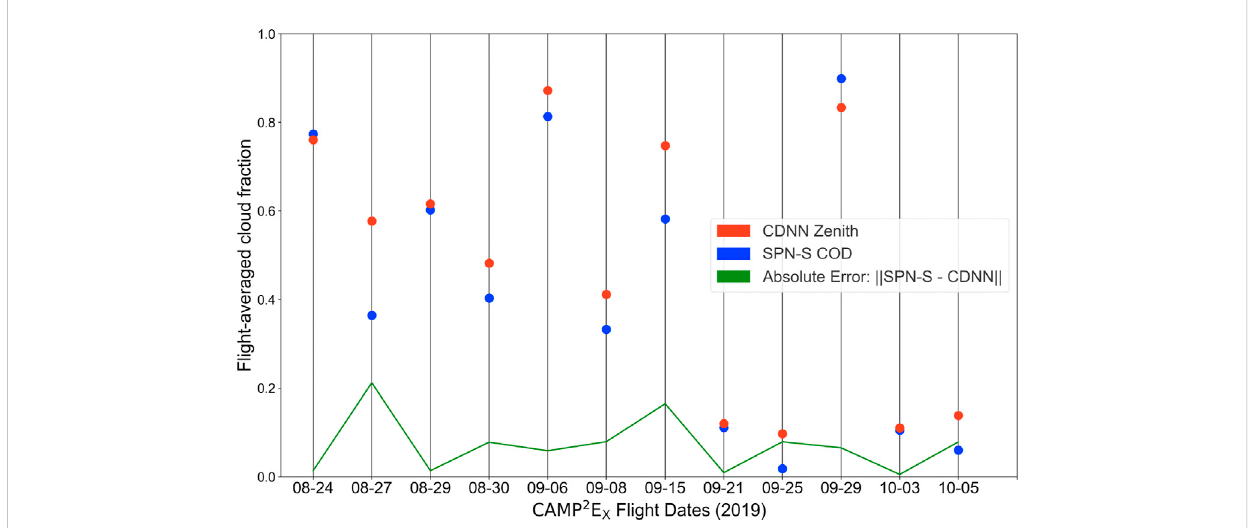
FIGURE 7 CAMP 2 Ex 2019 SPN-S vs CDNN fl ight-averaged cloud fraction. Zenith CDNN fl ight-averaged cloud fraction compared with SPN-S on a per CAMP 2 Ex research fl ight basis. Red dots indicate the zenith CDNN fl ight-averaged cloud fraction, whereas the blue dots represent the SPN-S fl ight- averaged cloud fraction. Flight-averaged cloud fractions are generated by averaging all zenith CDNN or SPN-S cloud mask values, described in Section 3.2.3. The green line presents the absolute error of the fl ight-averaged cloud fraction between the two different retrieval